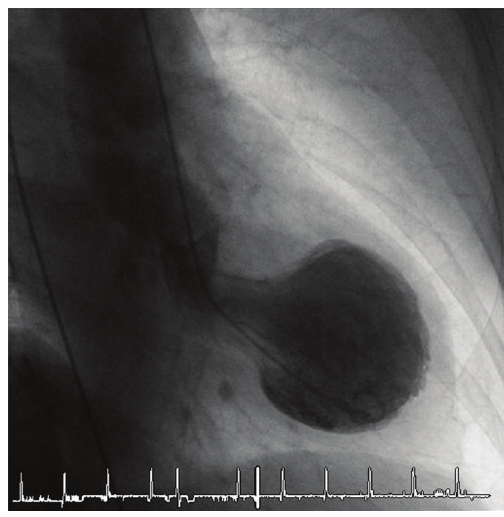
Figure 4: Angiogram showing a left ventricular dysfunction with preserved basal function and moderate-to-severe dysfunction in the midventricle and apical regions.